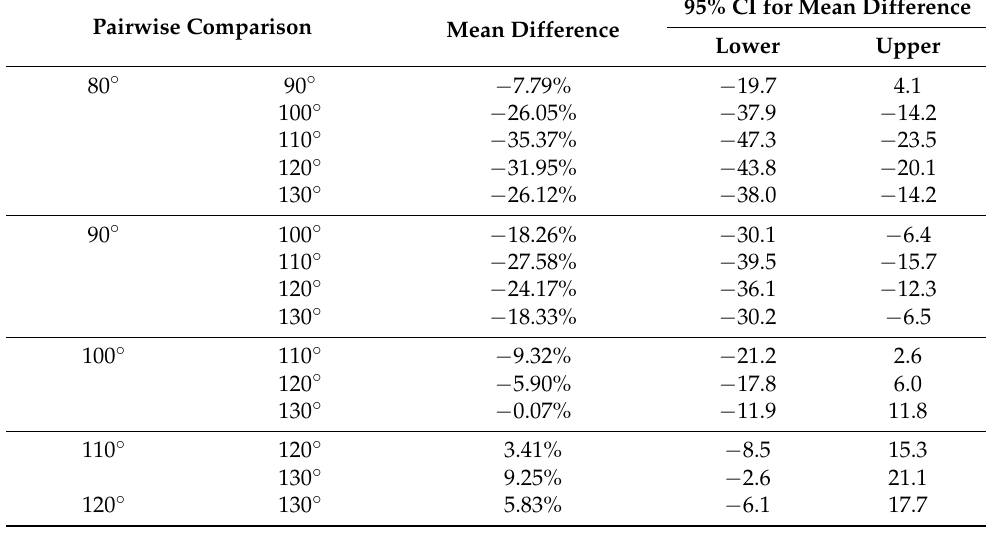
Table 2. Bonferroni post-hoc analysis for torque.